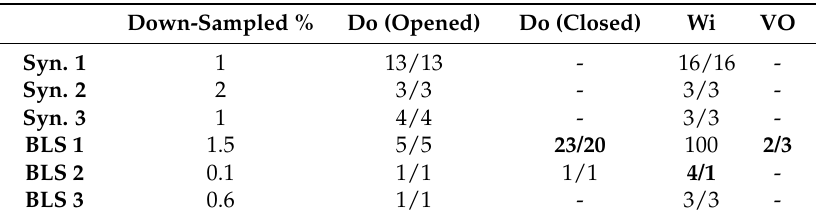
Table 4. Statistics of the output models compared to input datasets for wall-surface objects. Wo, window; Do, door; VO, virtual Opening. {out/input}. Down-Sampled % Do (Opened) Do (Closed) Wi VO 13/13 -